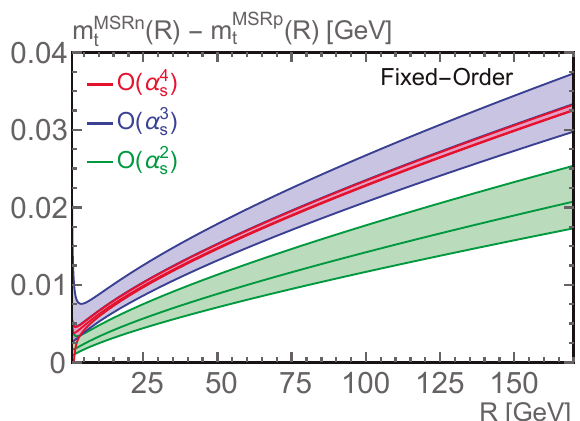
Figure 1. Di(cid:11)erence of the natural and practical MSR top quark masses ( n ‘ = 5) as a function of R in GeV at two, three and four loop order (the one loop result vanishes). The uncertainty bands are obtained from scale variations in (cid:11) s ( (cid:22) ) with R= 2 < (cid:22) < 2 R